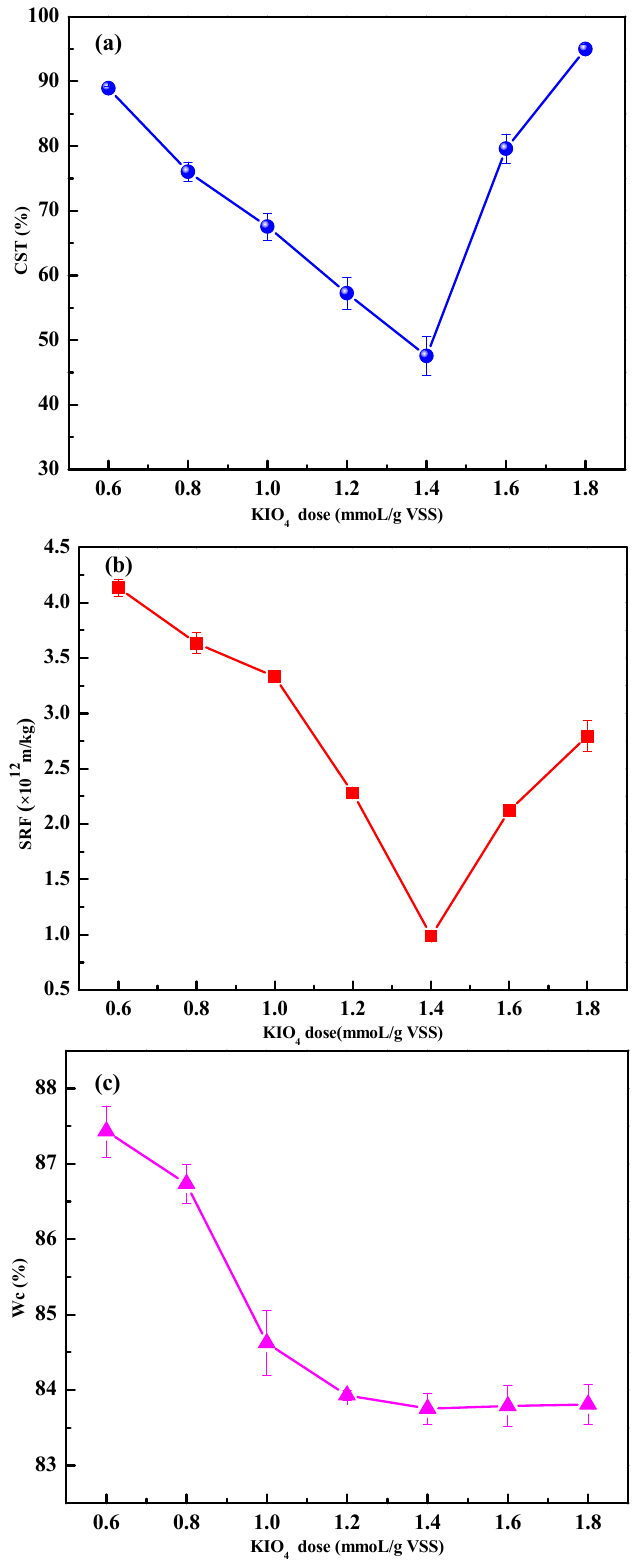
Figure 2. Effect of KIO 4 dose on performance indices of sludge dewatering. ( a ) CST, ( b ) SRF, and ( c ) W C . Conditions: Initial pH = 6.8; Fe( Ⅱ )/KIO 4 molar ratio = 1.2. With the KIO 4 dose increased from 0.6 to 1.4 mmol/g VSS, the CST, SRF, and Wc obviously decreased from 88.95 s, 4.14 × 10 12 m/kg and 87.43%, to 47.55 s, 0.99 × 10 12 m/kg